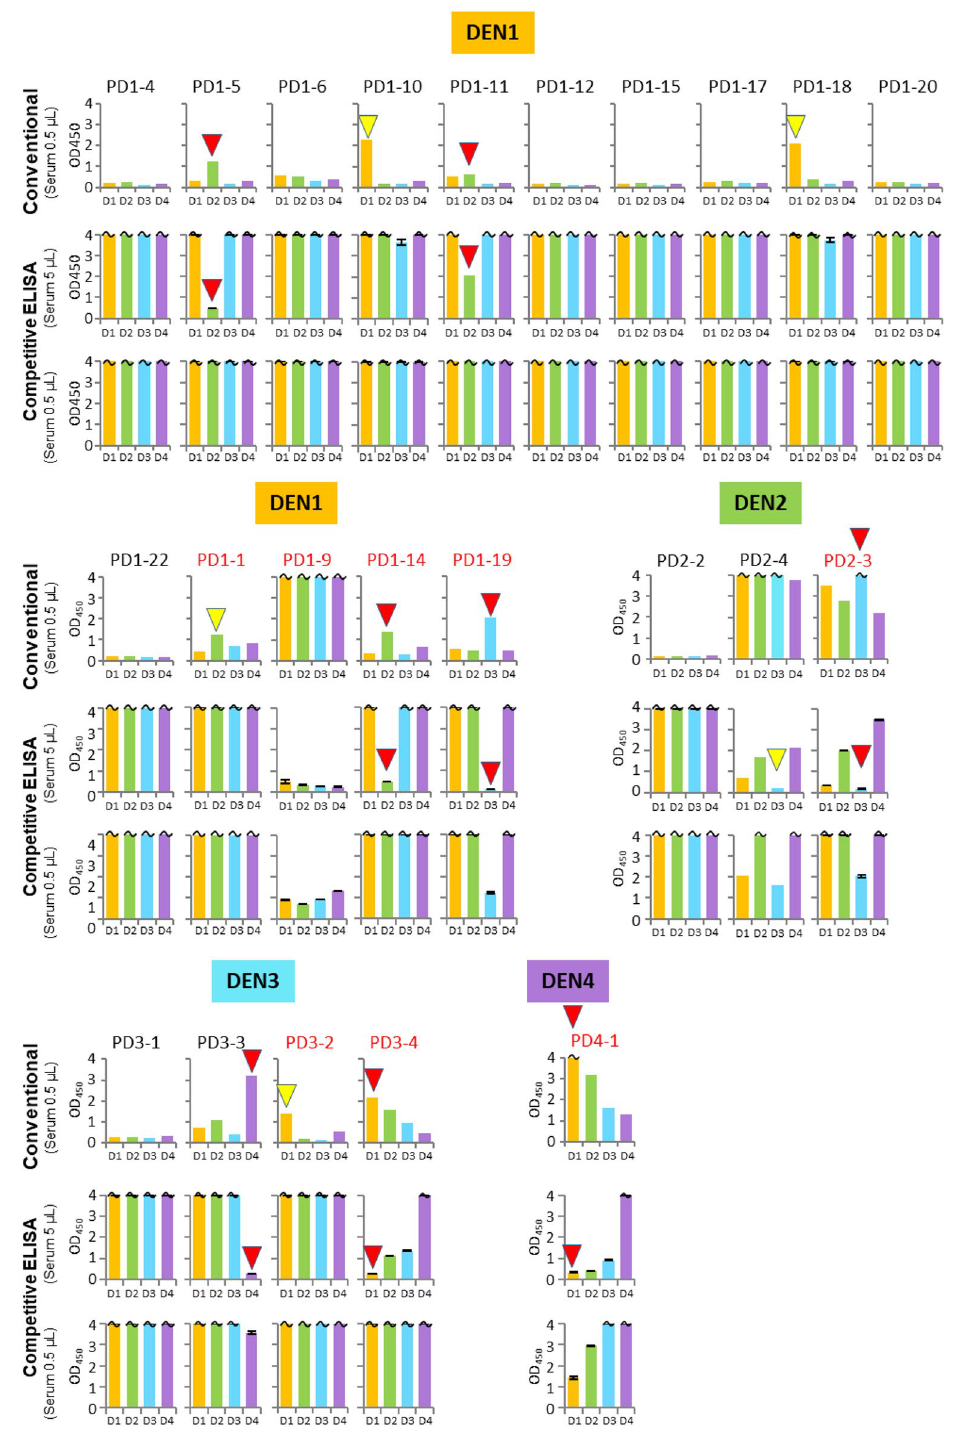
Figure 6. Comparison of the IgG detection sensitivity and selectivity using various clinical samples with two types of ELISA. Conventional: the direct IgG detection by the typical ELISA method in Figs. 1d and 5b using 0.5 µL of the serum or plasma samples. Competitive ELISA: the aptamer–DEN-NS1 binding inhibition by our competitive Apt/Ab ELISA (Figs. 1c and 5a) using 0.5 µL and 5 µL of the serum or plasma samples. The amounts of the spiked DEN-NS1 are indicated in Supplementary Fig. 1. The similar patterns of the serotype-specific IgG detection by both ELISA formats are indicated by red triangles. IgG detection patterns that differ between the conventional and competitive ELISA formats are indicated by yellow triangles. The patient sample names (indicated in red) were assigned as secondary infection by the LFA